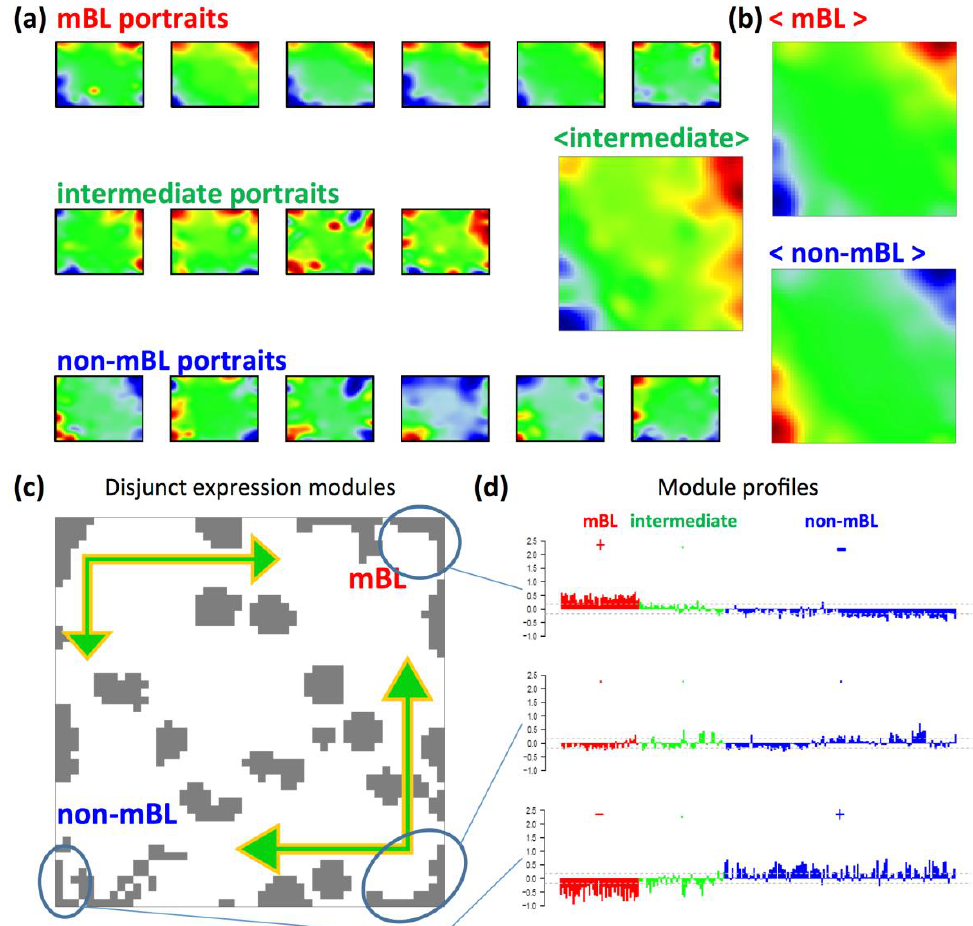
Figure 4: Results of the SOM analysis of the lymphoma data set. Expression portraits of selected samples are shown for each of the three subtypes (panel a). Red and blue colors indicate over- and underexpression in the samples, respectively, green color indicates intermediate levels of gene expression. Average subtype specific expression portraits reveal antagonistic expression modes of the mBL and non-mBL subtypes (panel b). Distinct spot-modules are identified (panel c), whose expression profiles change in a subtype-specific fashion (panel